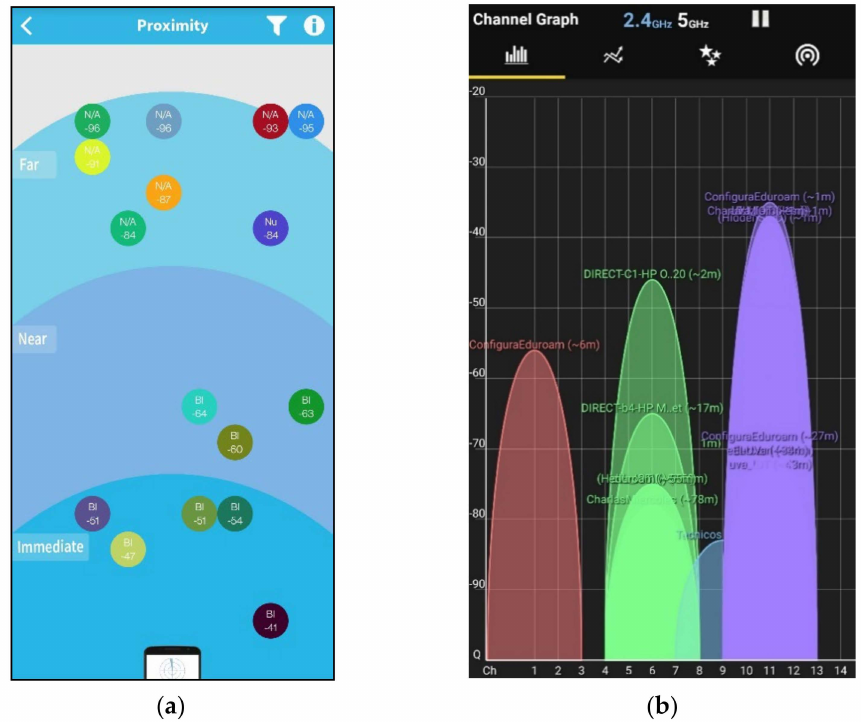
Figure 14. Final chosen location signals. ( a ) Bluetooth signals in the final crowded environment ( − 50 to − 40 dB); ( b ) Wi-Fi signals in the final crowded environment ( − 50 to − 35